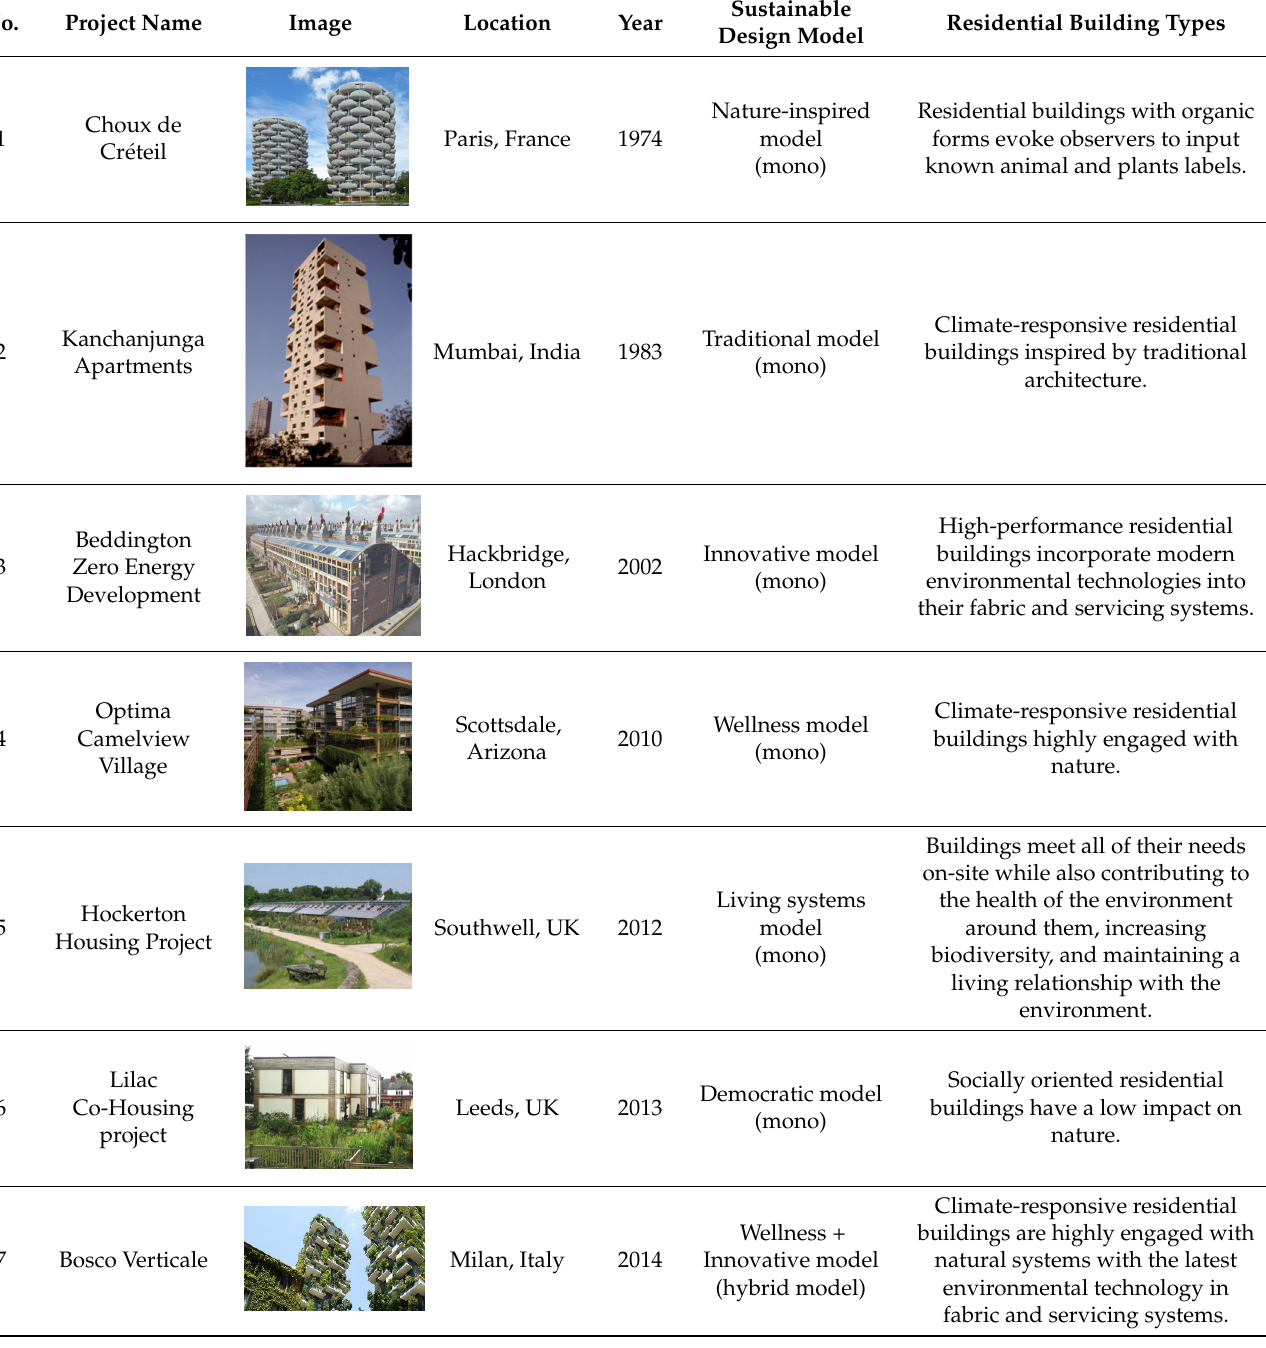
Table 2. Sustainable housing models in real practices (mono and hybrid model examples).